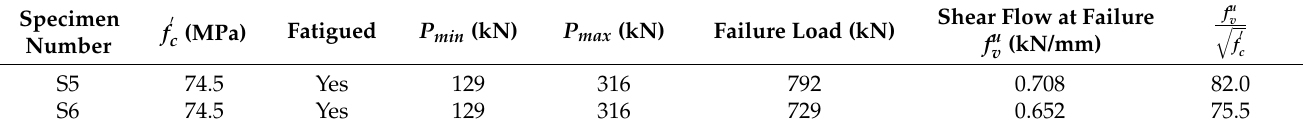
Table 4. Summary of Stainless Steel Connector Specimen Test Protocols and Strength Test